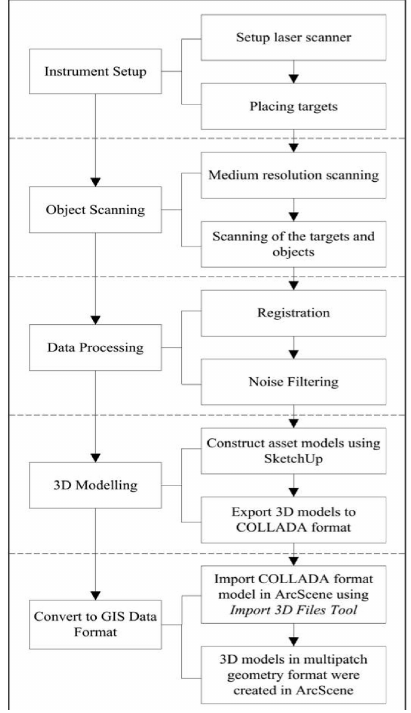
Figure 4. Workflow of 3D modelling based on point cloud